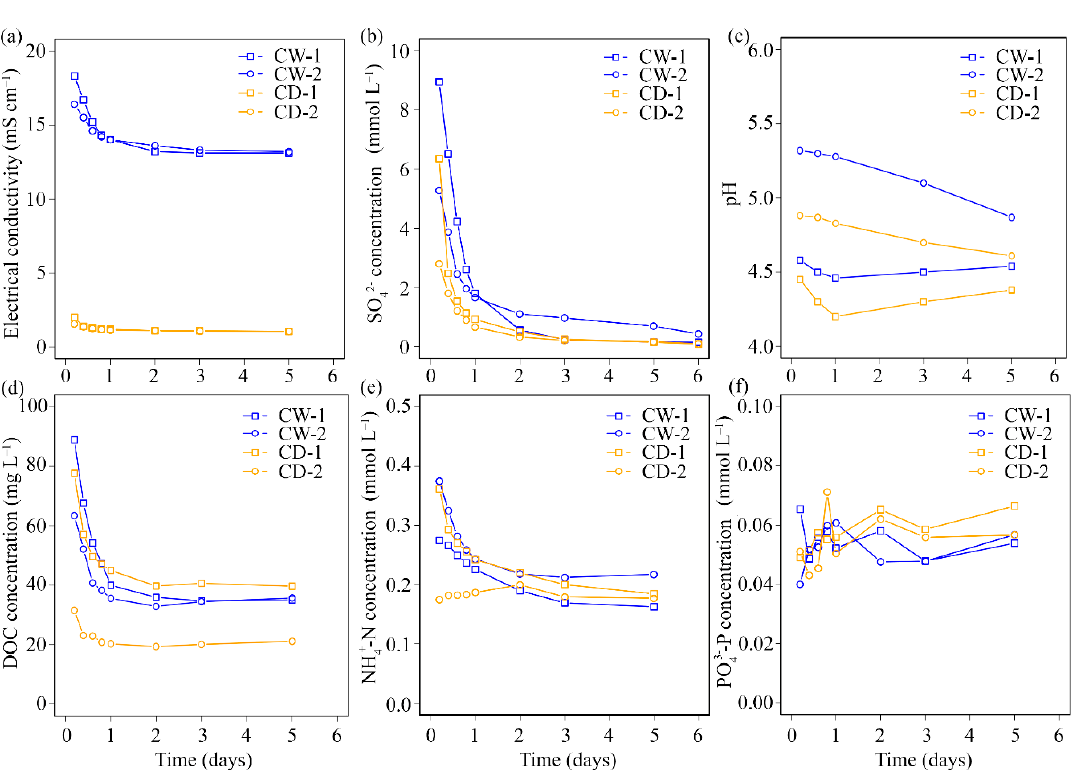
Figure 2. Initial nutrient flushing phase: ( a ) electrical conductivity, ( b ) sulfate (SO 42 − ), ( c ) pH, ( d ) dissolved organic carbon (DOC), ( e ) ammonium ( NH 4+ -N), and ( f ) phosphate ( PO 43− -P).